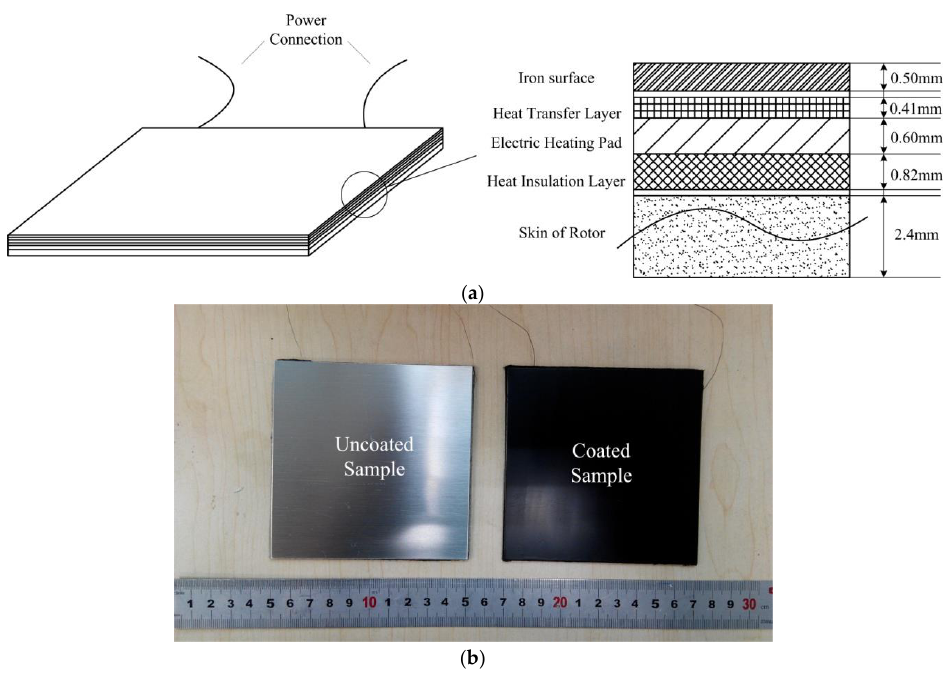
Figure 1. ( a ) Schematic of anti-/deicing component without graphene coating; ( b ) Photograph of uncoated sample and coated sample.